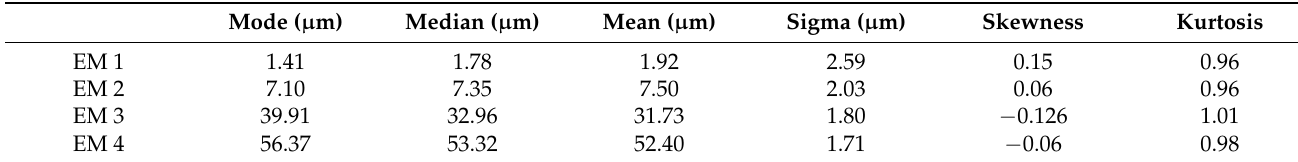
Table 1. Statistical parameters of each end member.